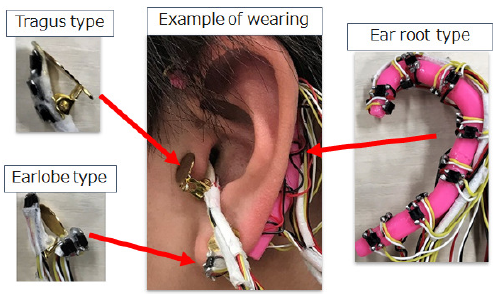
Figure 6. Example of wearing sensor devices. Reprinted/adapted with permission from Ref. [11] 2021, ACM.